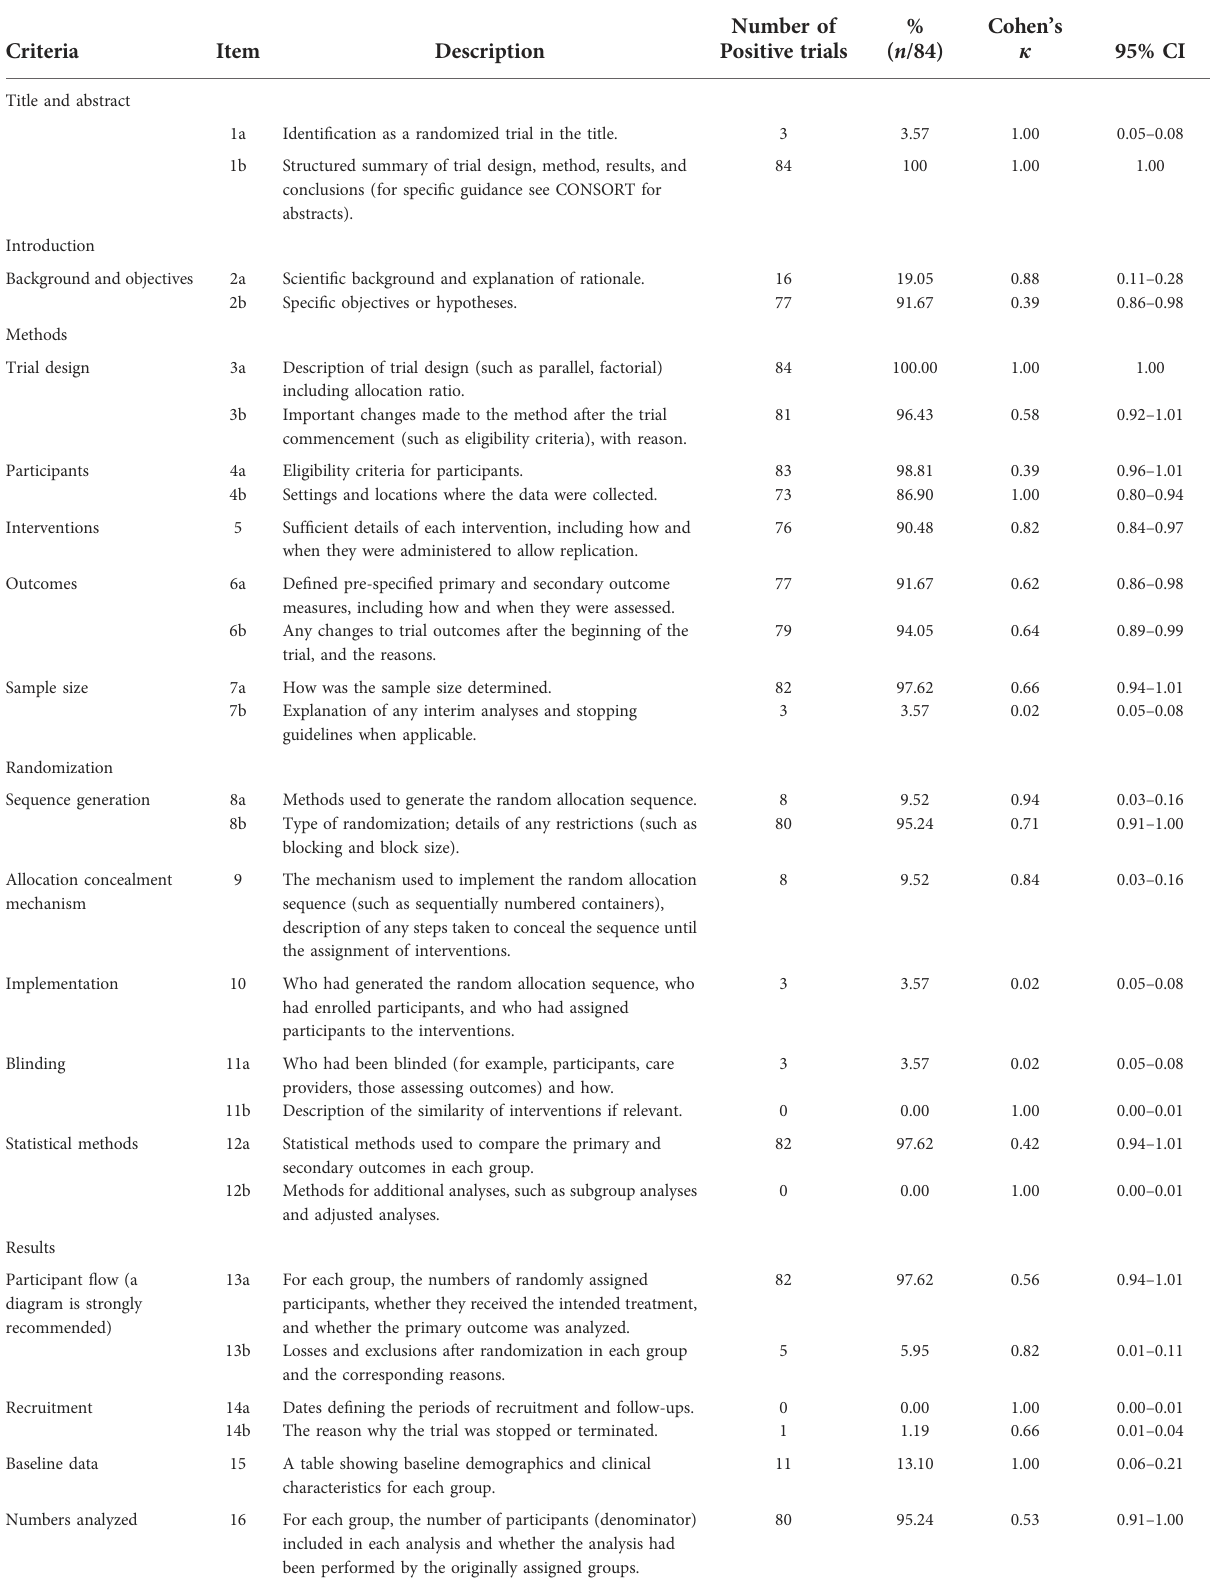
TABLE 1 Assessment of reporting quality using items from the CONSORT statement ( n =84studies).